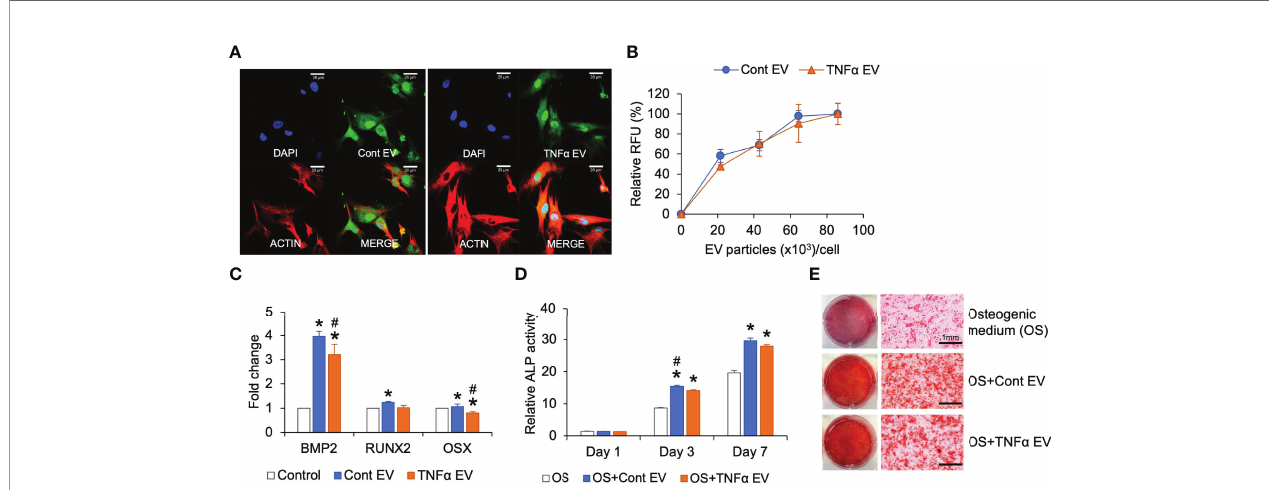
FIGURE 2 | Effect of TNF a EVs on MSC osteogenic differentiation. (A) Representative confocal images of fl uorescently labeled control and TNF a EVs (green) endocytosed by MSCs. Scale bar=20 m m in all images. The red staining in the images indicate actin counter stain and blue staining shows the nuclei (DAPI). (B) Dose-dependent and saturable endocytosis of fl uorescently labeled control and TNF a EVs by MSCs. (C) Fold change in the expression of osteoinductive marker genes in MSCs in the presence of control and TNF a EVs (72hrs post treatment) in the presence of growth medium. Data represents fold change with respect to no EV controls. Note that TNF a preconditioning does not generate osteoinductive property in MSC EVs. (D) ALP activity in MSCs cultured in osteogenic differentiation medium in the presence/absence of control or TNF a EVs. Note that while EVs increase ALP activity in general, TNF a preconditioning does not increase osteoinductive potential. (E) Representative images of alizarin red stained MSC cultures after 14 days of culture in osteogenic medium in the presence/absence of EVs. Note that while EV presence increased calcium deposition, no change was observed between control and TNF a preconditioned groups. *: statistical signi fi cance (P < 0.05) with respect to untreated control, #: statistical signi fi cance (P < 0.05) between control and TNF a EV groups as calculated by Tukey ’ s test post